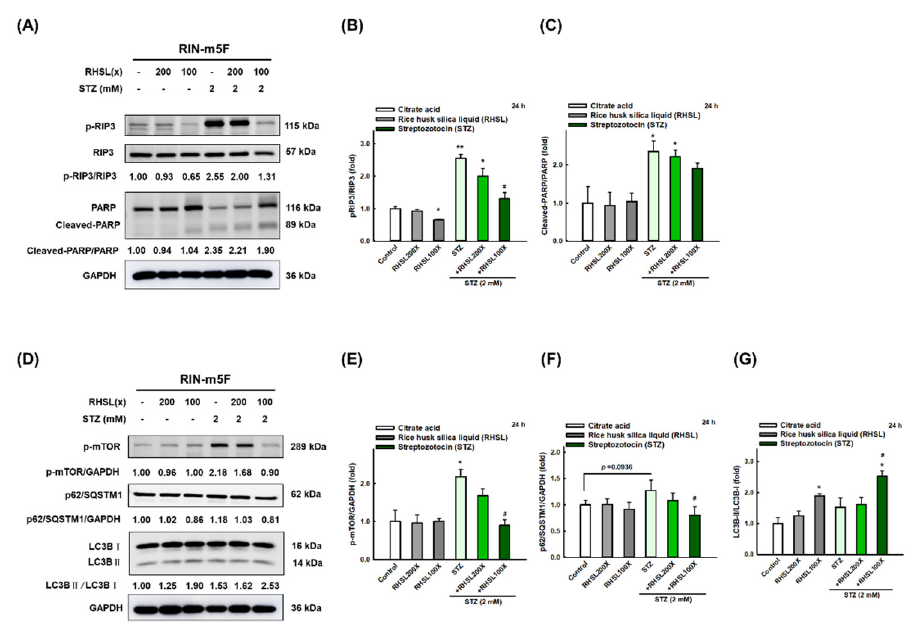
Figure 3. RHSL reverses STZ-induced cell death in RIN-m5F cells. Following treatment with RHSL in the absence or presence of ( A , D ) STZ (2 mM) for 24 h. Representative immunoblot for quantifi- cation of p-RIP3 ( B ), cleaved-PARP ( C ), p-mTOR ( E ), p62/SQSTM1 ( F ), and LC3B ( G ) expression in RIN-m5F. The optical densities of bands in each lane were normalized to GAPDH (loading control) optical density from the same gel. * p < 0.05; ** p < 0.001 compare with each control group (citrate acid). # p < 0.05 compare with STZ group.